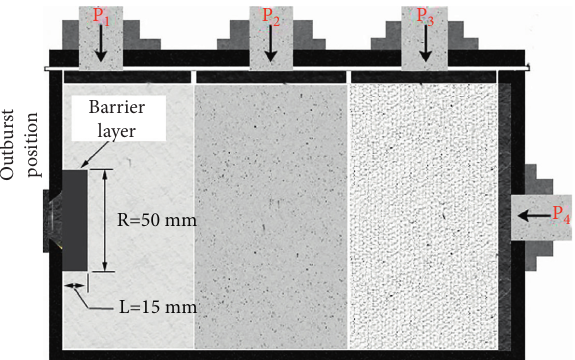
Figure 3: Stress distribution loaded on coal specimens and layout of yellow